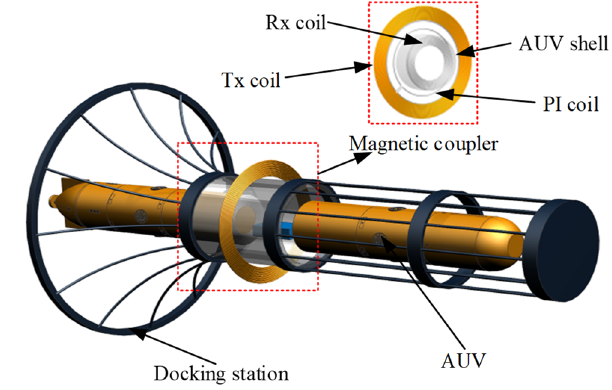
Figure 5. Proposed WPT system with a PI coil for AUV.